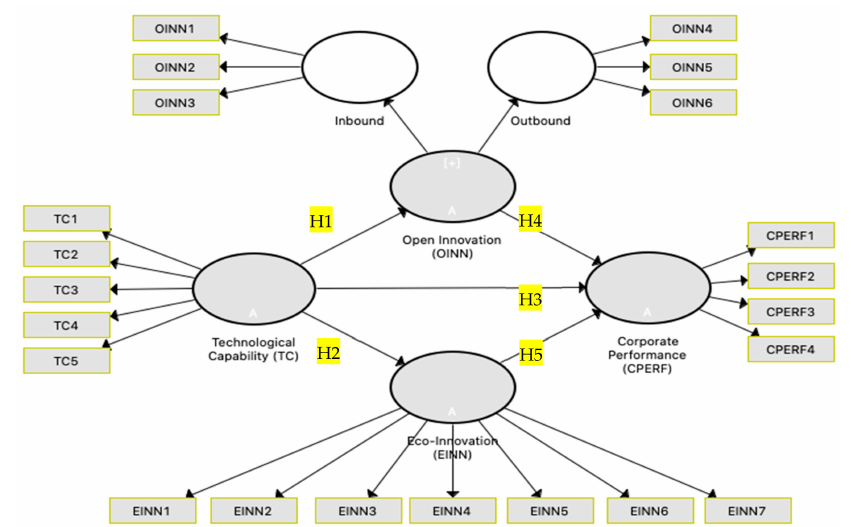
Figure 1. Nomogram of the